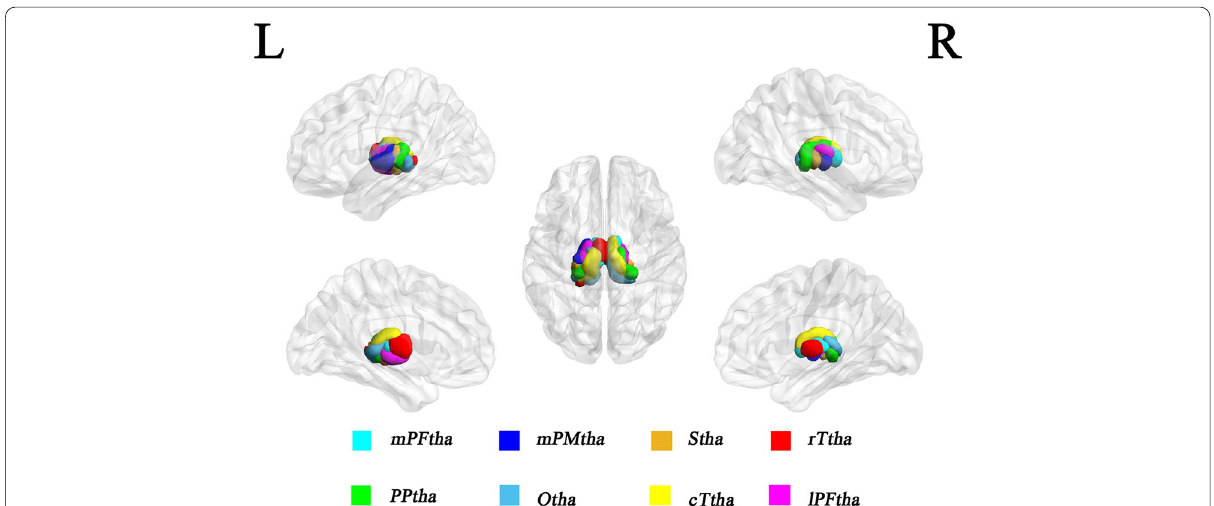
Fig. 1 Illustration of subregions of the bilateral thalami. Abbreviations: mPFtha, medial prefrontal thalamus; mPMtha, premotor thalamus; Stha, sensory thalamus; rTtha, rostral temporal thalamus; PPtha, posterior parietal thalamus; Otha, occipital thalamus; cTtha, caudal temporal thalamus; lPFtha, lateral prefrontal thalamus; L, left; R,